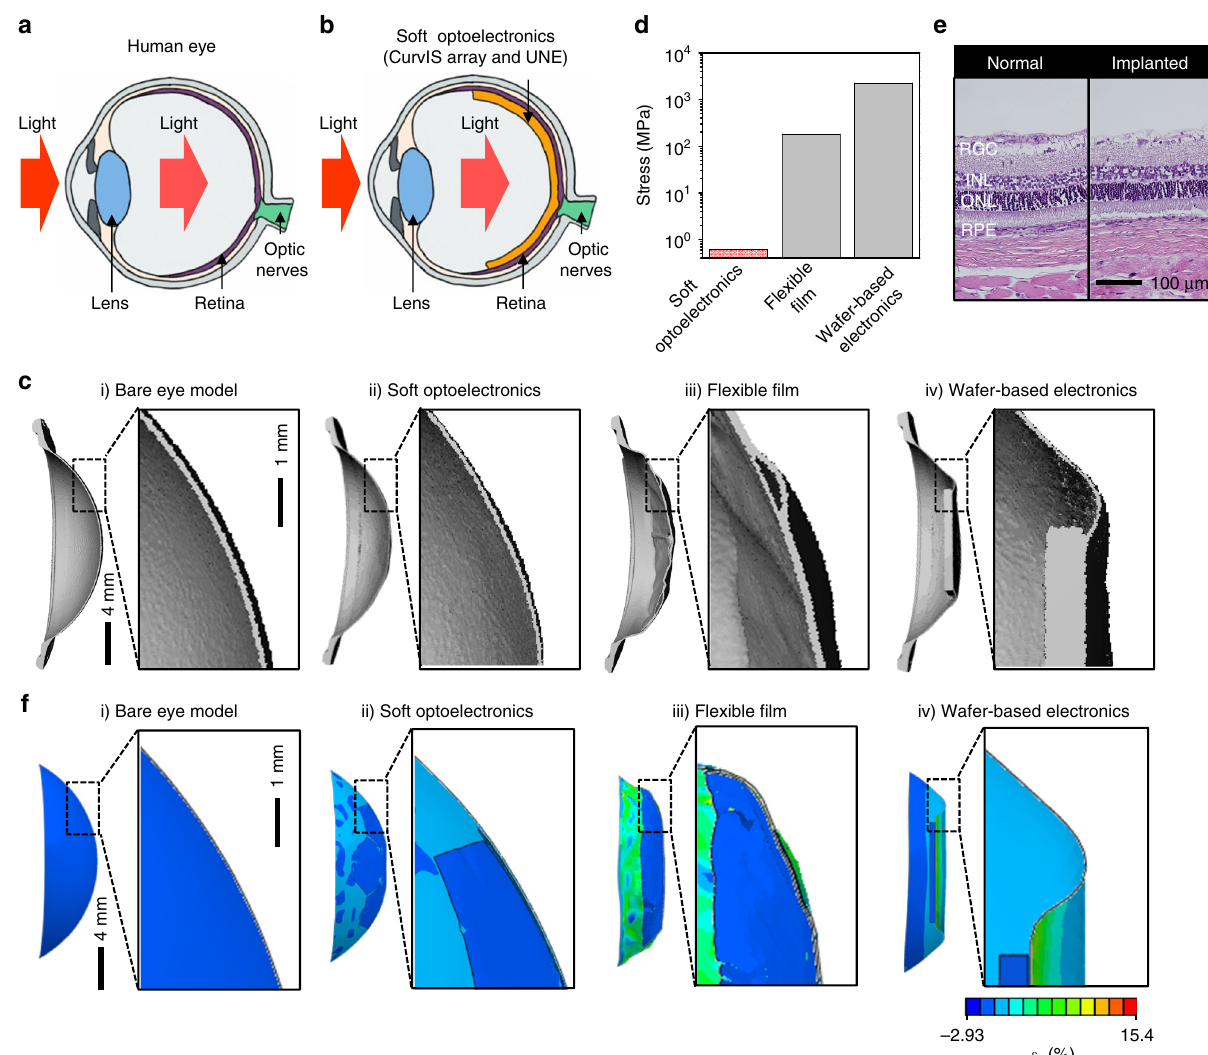
Fig. 4 Human eye-inspired soft optoelectronic device. a Schematic illustration showing the ocular structure of human. b Schematic illustration showing the ocular structure with the soft optoelectronic device. c Micro CT image (left) and magni fi ed image (right) showing deformation of (i) the bare eye model, attached by (ii) the soft optoelectronic device, (iii) a fl exible fi lm device, and (iv) wafer-based electronics. d Induced Stress by three different implanted devices. e The H&E stain histology of the normal retina and the retina implanted with the soft optoelectronic device. f FEA results of the maximum principal strain in eye model (i) without any device, (ii) with the soft optoelectronic device, (iii) with a fl exible fi lm device, and (iv) with